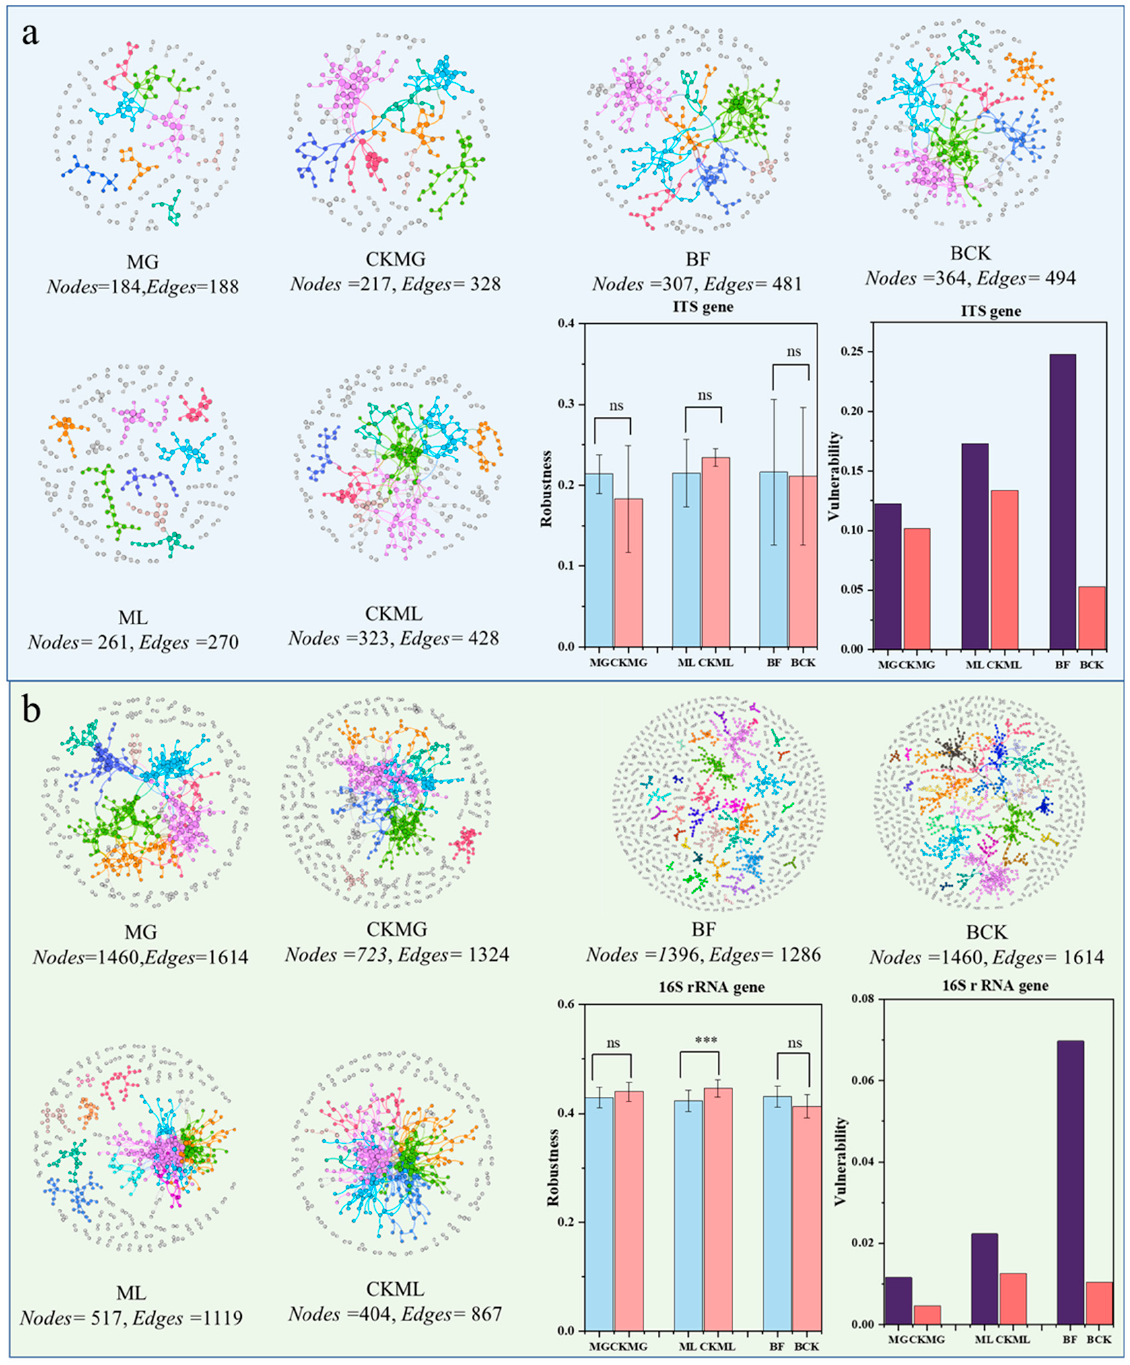
Figure 4. Networks of microbial communities in soils with or without OF amendment. Each node represents an OTU. The links between nodes show strong and significant correlation ( p < 0.01). Modules are represented in different colors, and nodes in modules with less than 10 members are represented in gray. Visualization of the stability (robustness and vulnerability) of the rhizosphere soil microbial network in grass–legume mixtures. ( a ) Fungal community. ( b ) Prokaryote community. In the grass–legume mixtures, MG represents rhizosphere samples of grass OF; CKMG represents rhizosphere samples of grass non-OF; ML represents rhizosphere samples of legume OF; CKML represents rhizosphere samples of legume non-OF; BF represents bulk soils samples of OF; BCK represents bulk soil samples of non-OF. *** represent significance at p < 0.001, ns represents no significance, respectively.